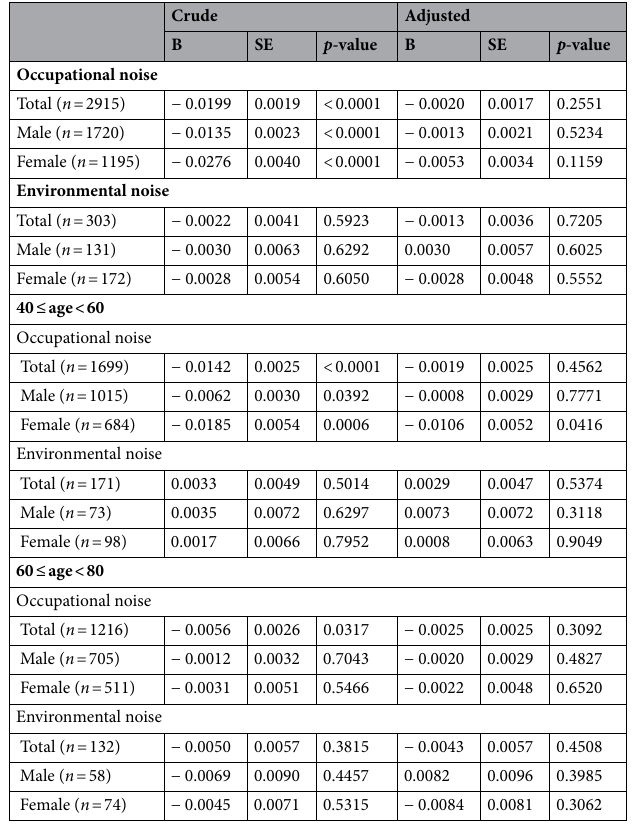
Table 3. Results of the linear regression analysis for noise exposure time and the eGFR. Adjusted for age, sex, educational state, household income, urbanity, hypertension, diabetes, dyslipidemia, body mass index, smoking, high-risk alcohol consumption, and aerobic physical activity. eGFR glomerular filtration rate, SE standard